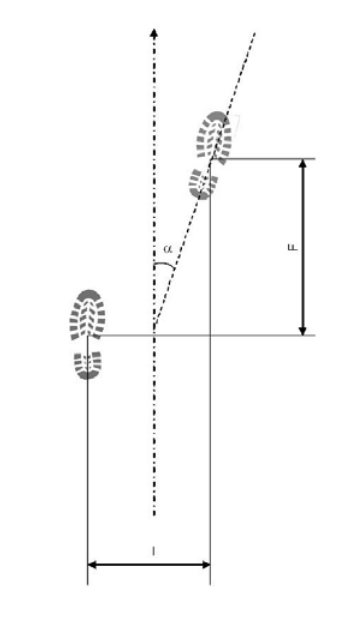
Figure 10. Parameters controlling a human